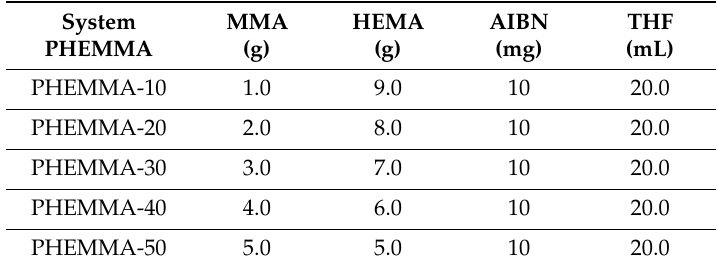
Preparation conditions of poly(2-hydroxyethylmethacrylate-co-methylmethacrylate) (PHEMMA)